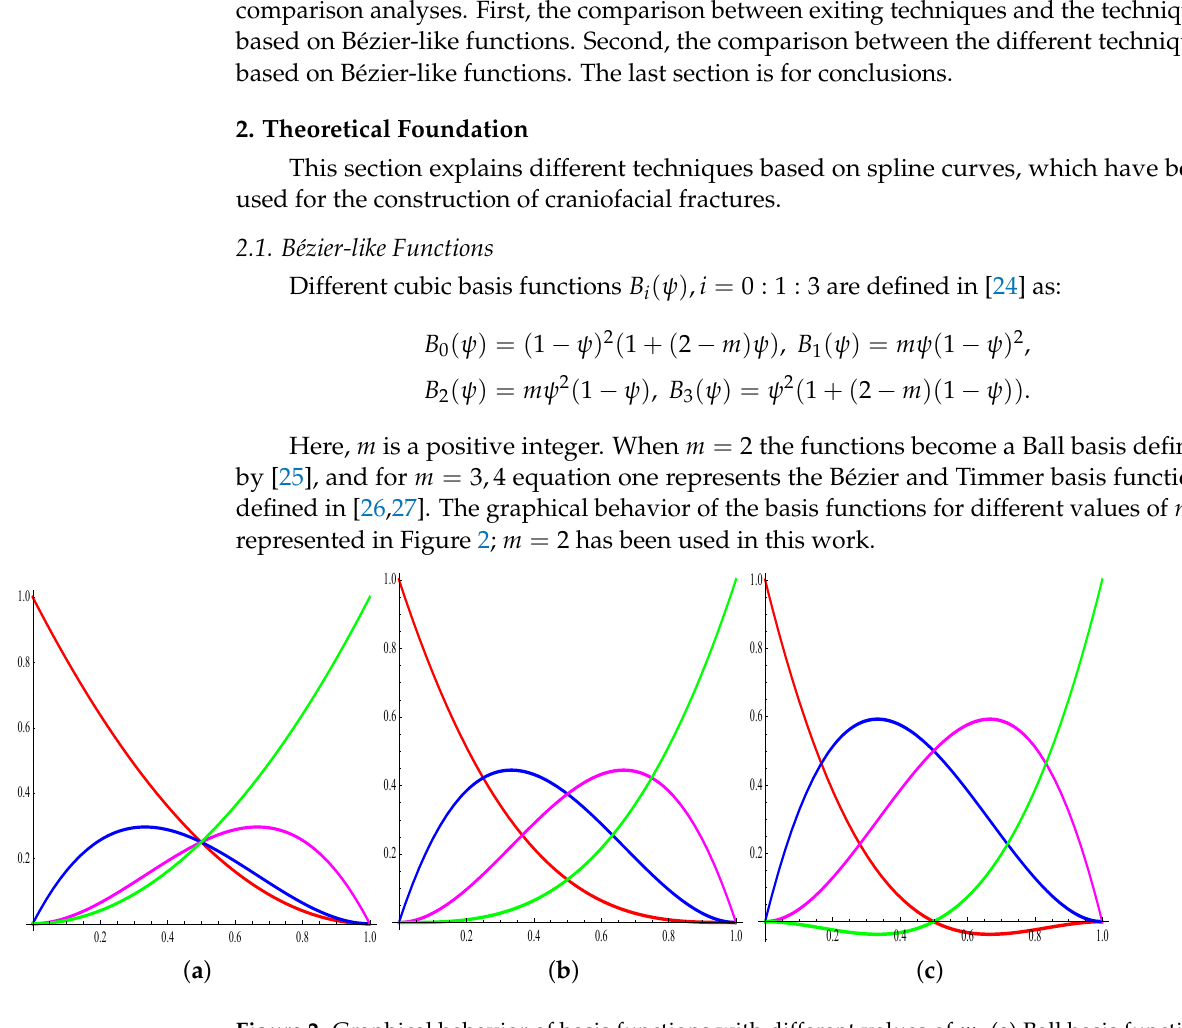
Figure 2. Graphical behavior of basis functions with different values of m . ( a ) Ball basis functions ( m = 2 ) ; ( b ) Bézier basis functions ( m = 3 ) ; ( c ) Timmer basis functions ( m = 4 )